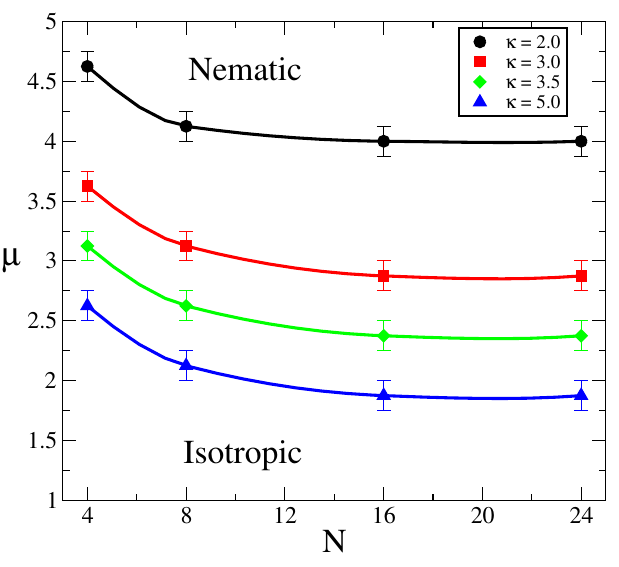
Figure 2. Phase diagram in the parameter space ( µ , N ) for different degrees of flexibility, parametrized by κ , obtained by Monte Carlo simulations. Symbols indicate the transition values, µ t , at which the isotropic-nematic transition occurs. Lines are only a guide to the eye. The associated persistence lengths, from small to large κ values, are: (cid:96) p / b ≈ 1.6,2.5,3.0 and